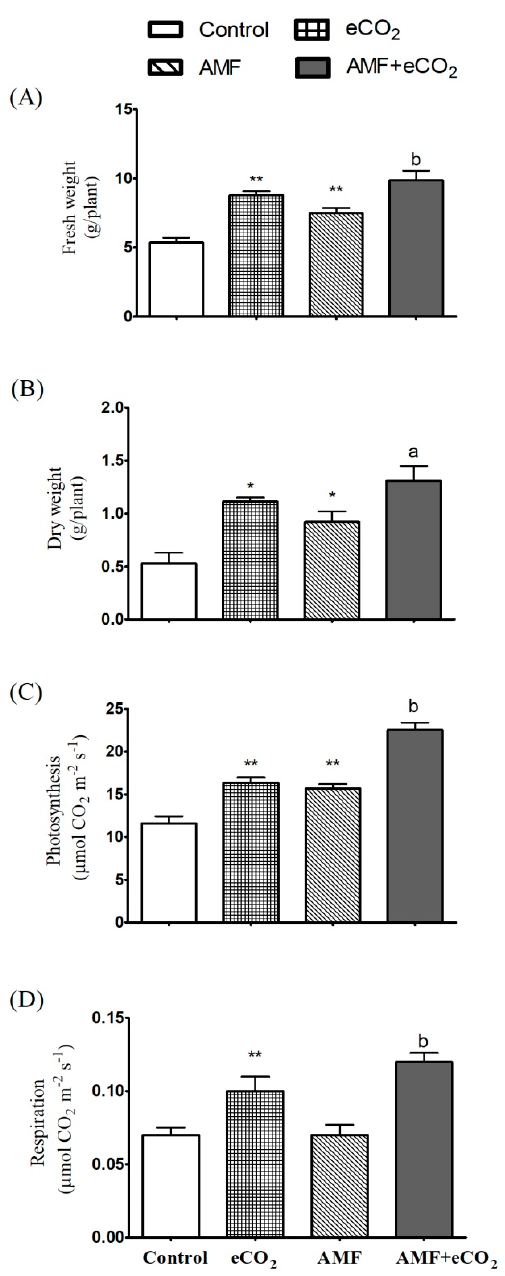
Figure 1. Fresh mass ( A ), dry mass ( B ), and rates of photosynthesis ( C ) and respiration ( D ) in Thymus vulgare grown under normal conditions (control) or the e ff ect of eCO 2 (620 ppm), AMF or their combination (AMF-eCO 2 ). Values are mean ± standard error of five independent replicates. Asterisks indicate significant changes (* p < 0.05; ** p < 0.01) compared to control, as revealed by the Student’s t -test. Lowercase letters indicate significant differences ( a p < 0.05; b p < 0.01) between AMF alone and the combined AMF+eCO 2 treatment.